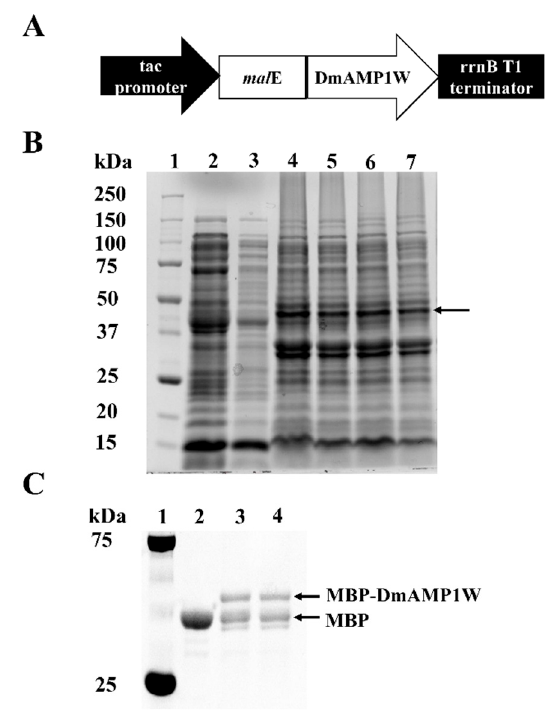
Figure 1. Expression and purification of MBP-DmAMP1W. ( A ) Construction of pMAL-C5X- DmAMP1W prokaryotic expression vector. In Escherichia coli , mal E- DmAMP1W was predicted to encode the recombinant protein MBP-DmAMP1W. ( B ) SDS-PAGE (12%) analysis of MBP and MBP- DmAMP1W fusion protein. Lane 1, protein marker. Lane 2 and 3, the supernatant of cell lysate of pMAL-C5X DE3. Lanes 4–7, the supernatant of cell lysate of pMAL-C5X-DmAMP1W DE3. The black arrow represents the target protein. ( C ) SDS-PAGE analysis of the purified MBP and MBP- DmAMP1W fusion protein. Lane 1, protein marker. Lane 2, purified MBP tag protein. Lane 3 and 4, purified MBP-DmAMP1W fusion